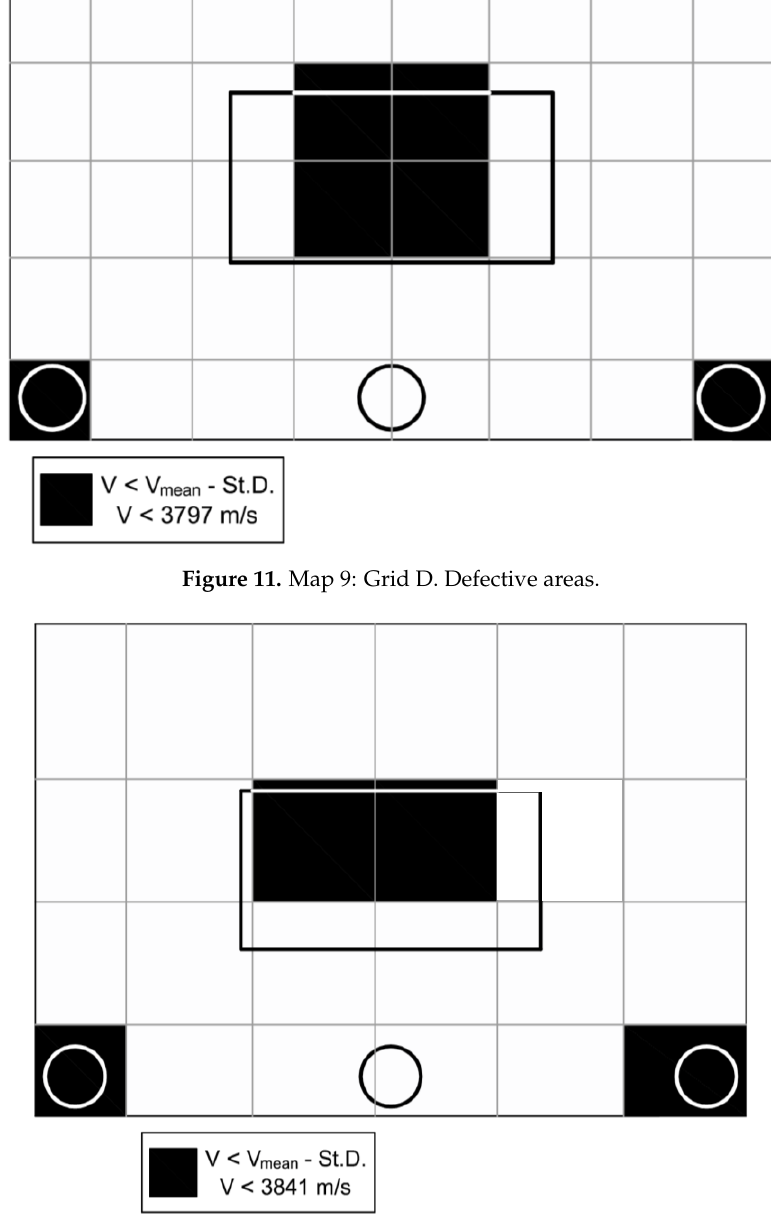
Figure 12. Map 10: Grid E. Defective areas.